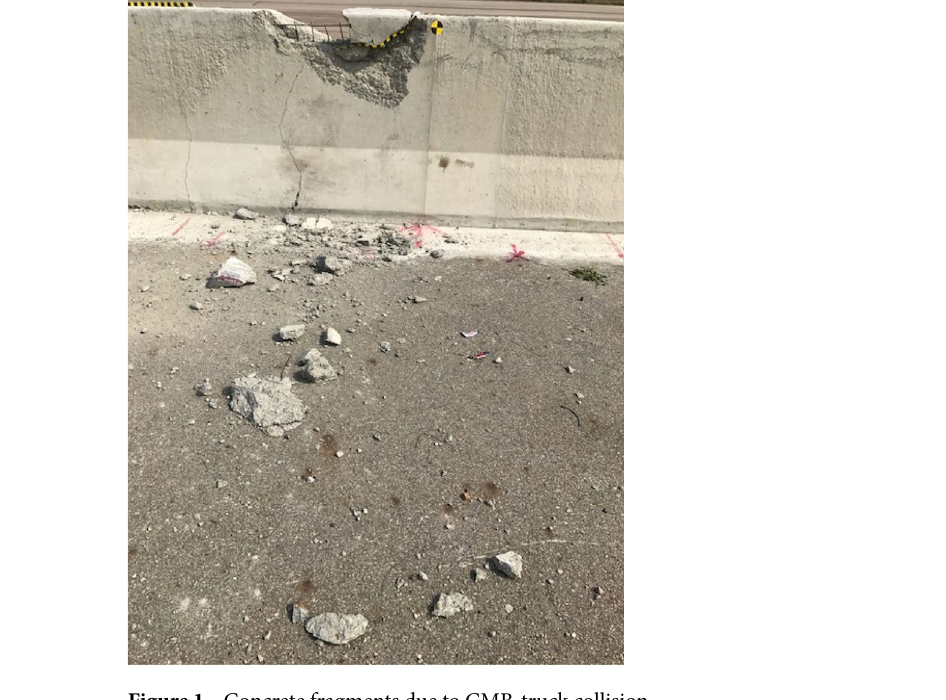
Figure 1. Concrete fragments due to CMB-truck